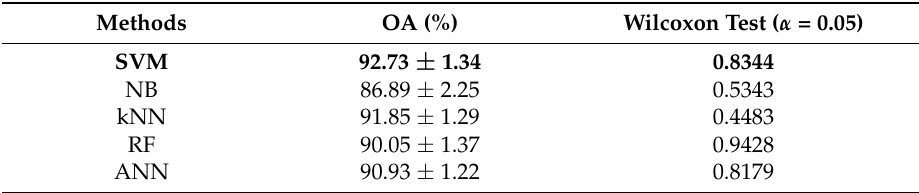
Table 2. Accuracies of MOSCRF based on different classifiers.